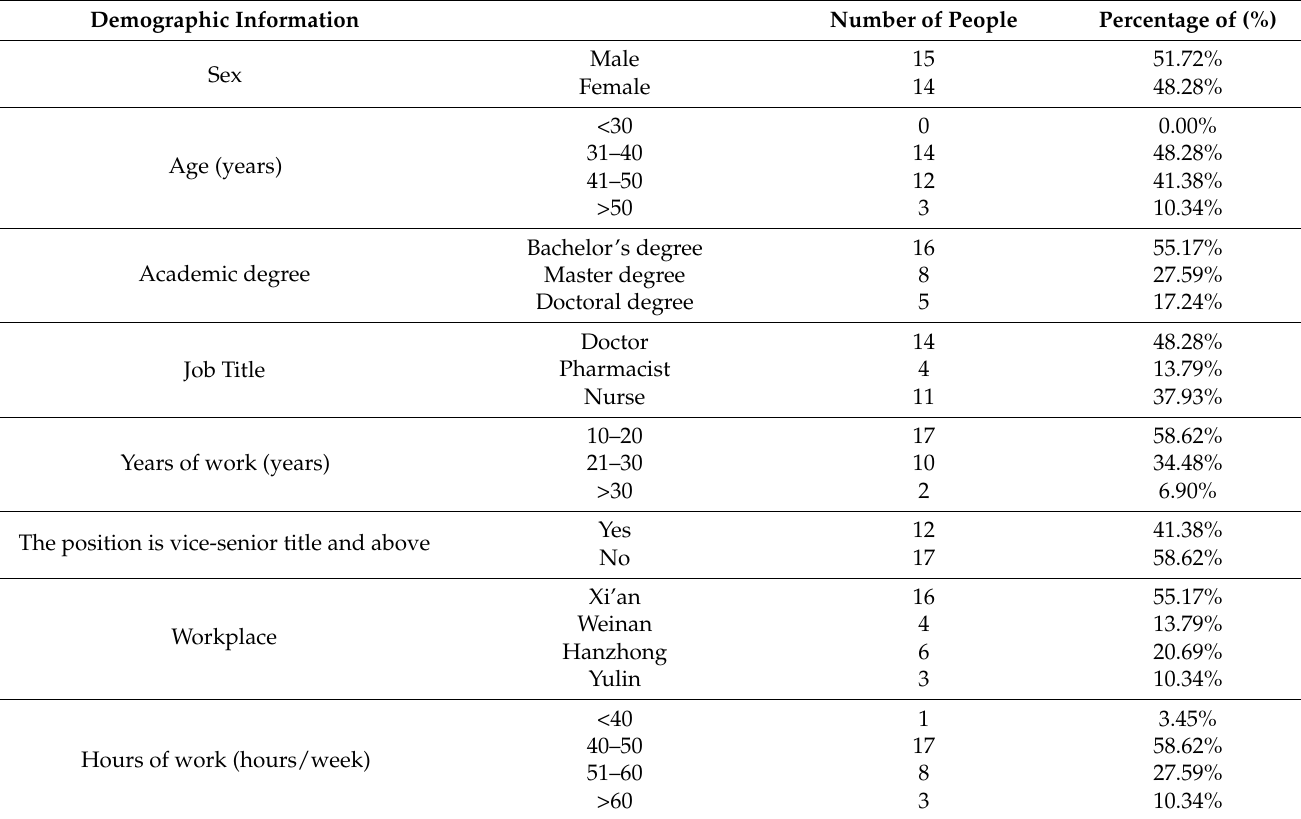
Table 2. Basic information of raters.